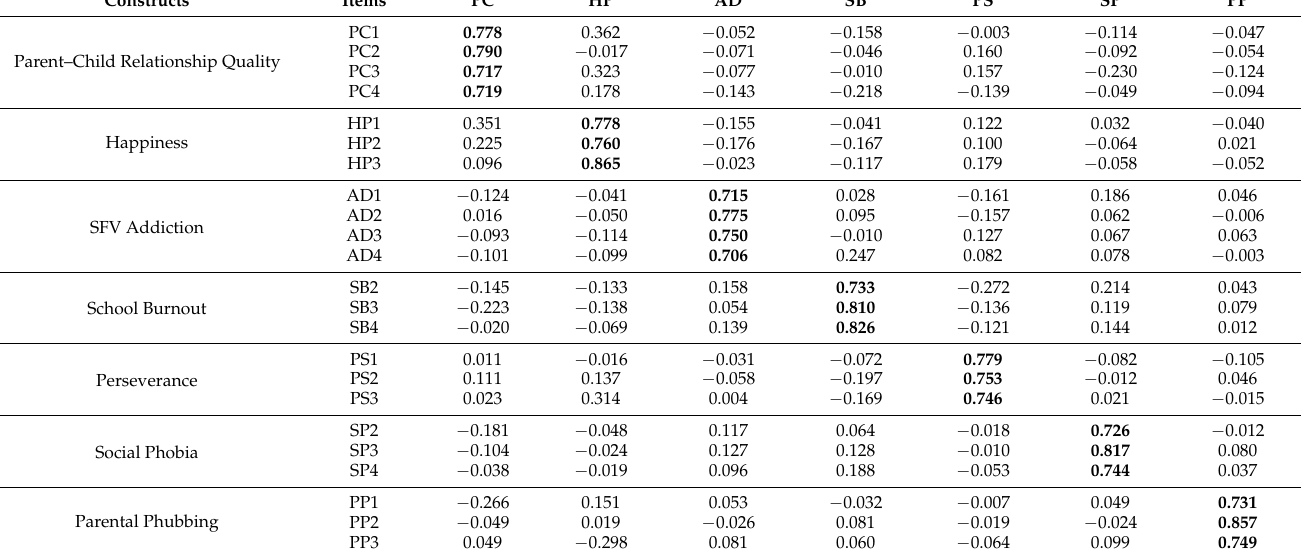
Table 4. Loadings and